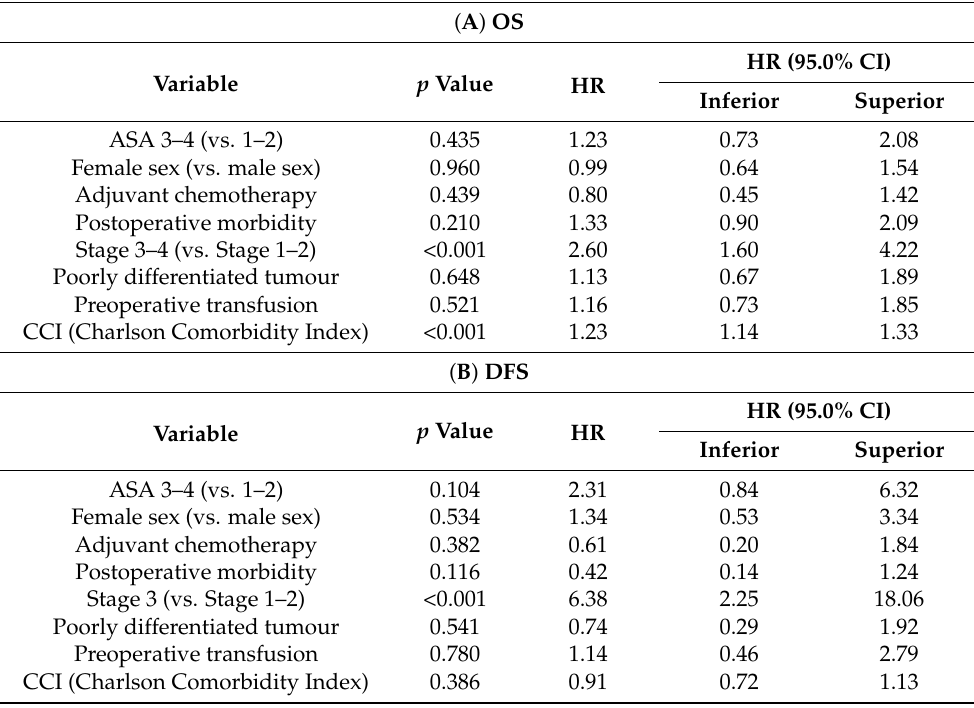
Table 4. Multivariate analysis for overall survival ( A ) and disease-free survival ( B ) in patients with moderate to severe anaemia.